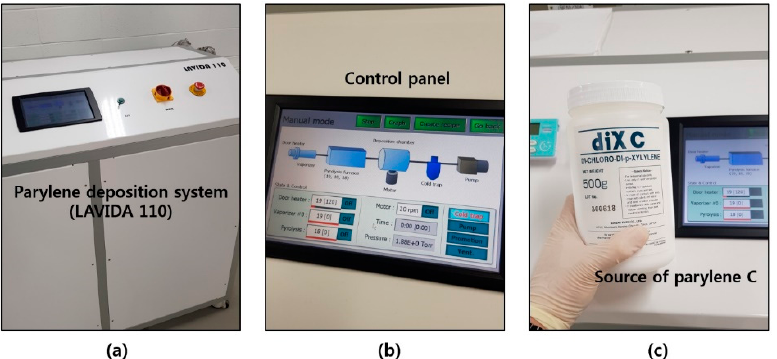
Figure A3. Photographs of the chemical vapor deposition (CVD) system for the preparation of Parylene C films: ( a ) Photograph of Parylene CVD (LAVIDA 110); ( b ) photograph of control panel of Parylene CVD; ( c ) photograph of a source material for Parylene C, di-chloro-p-xylylene.